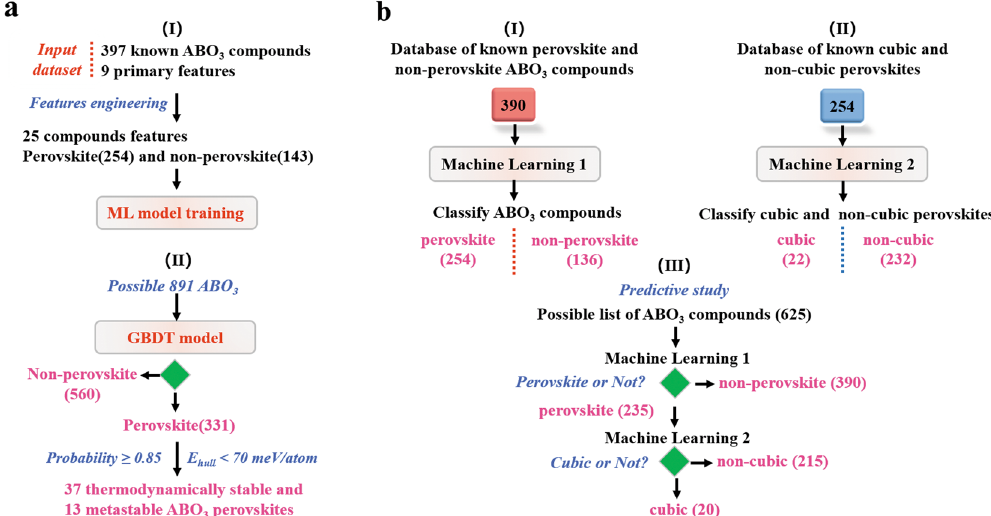
Fig. 5 Work fl ows of ML in ABO 3 perovskites. a Work fl ow for predicting stability and metastability of ABO 3 perovskite. Reproduced with permission from ref. 62 . Copyright Elsevier 2020 b Work fl ow for the ABO 3 cubic perovskite 65